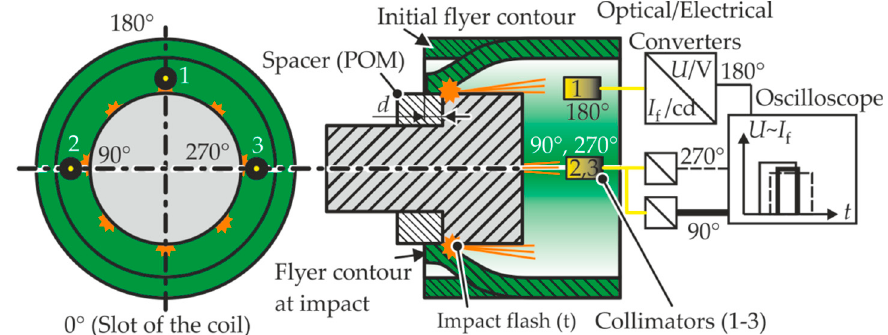
Figure 2. Modified MPW setup for investigation of the flyer kinetics with collimators (1–3) for flash detection (not true to scale, position of all parts is fixed during MPW).